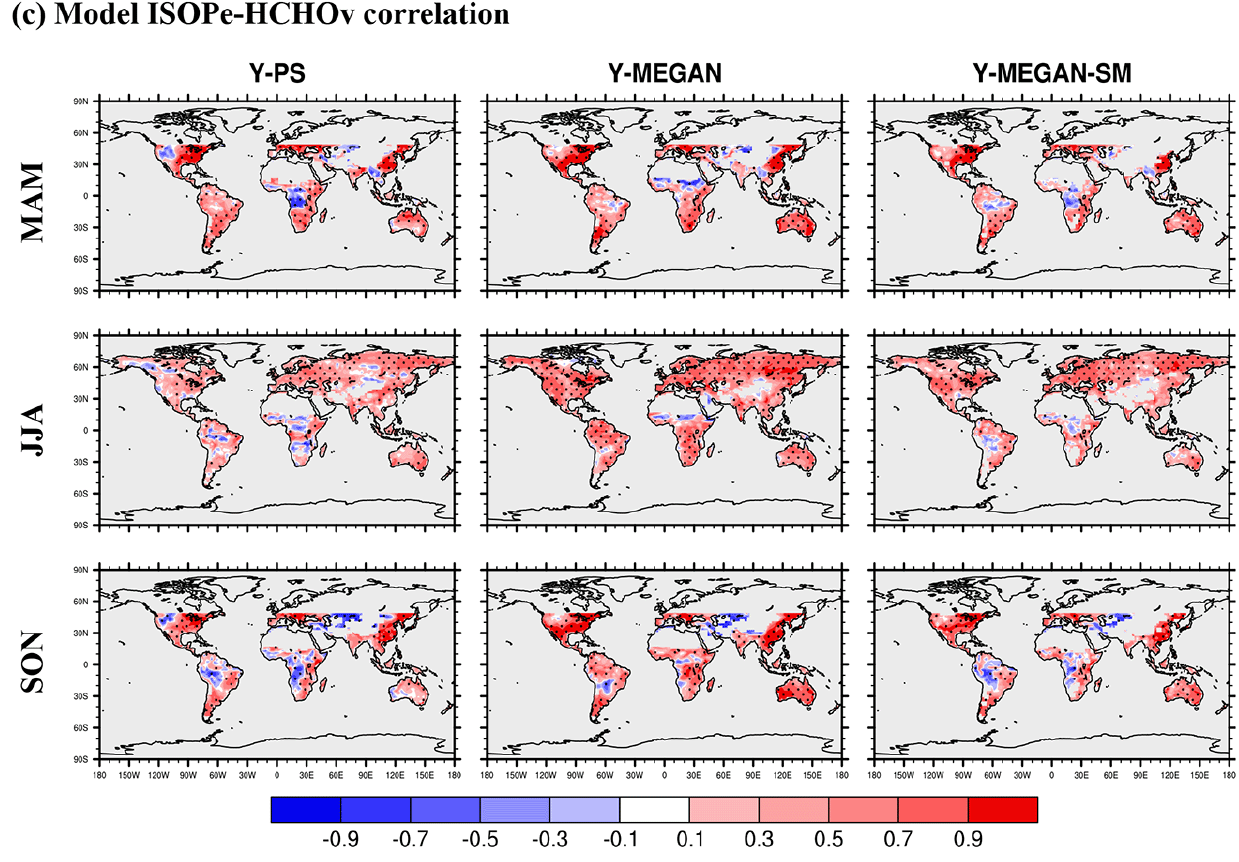
Figure 4. Simulated correlation between monthly mean (a) GPP and HCHOv, (b) GPP and ISOPe, (c) ISOPe and HCHOv in MAM, JJA and SON using three isoprene algorithms: Y-PS, Y-MEGAN and Y-MEGAN-SM. Significant regions ( p <0.05) are shown with dotted